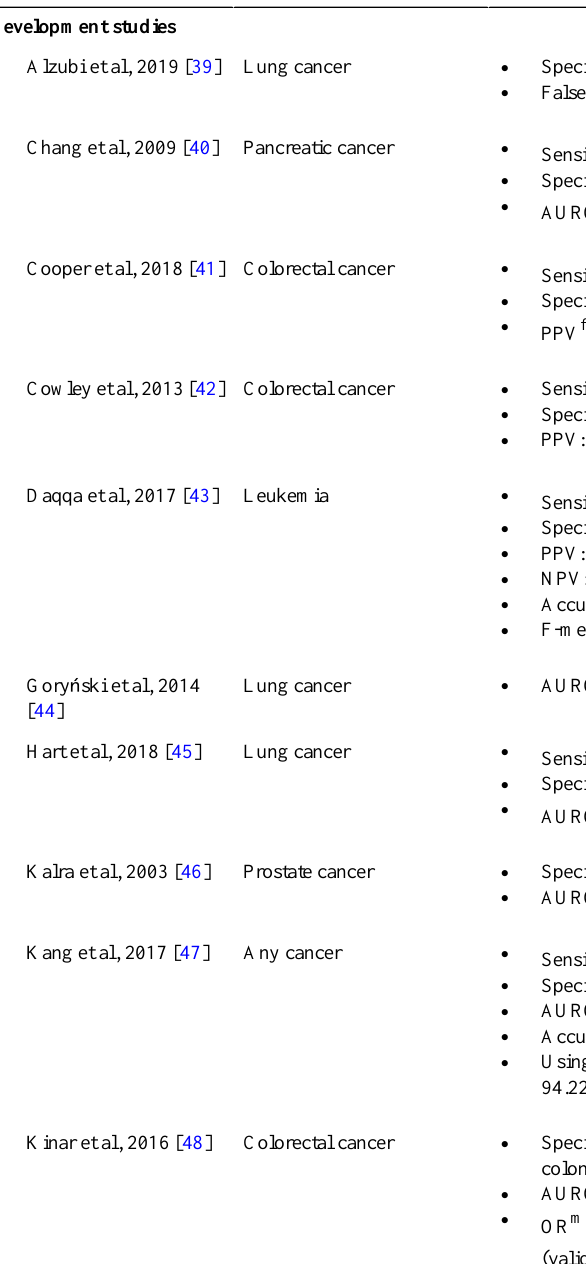
Table 4. Outcome measures. Development